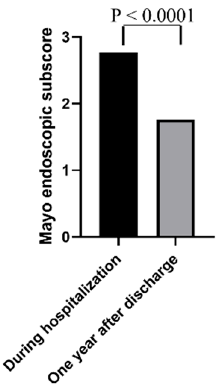
Figure 2. Kaplan–Meier curves of 88 patients with acute severe UC responding to intravenous corticosteroids (IVCS). Data about the relapse-free survival during the follow-up are shown according to maintenance therapy. 5-ASA = 5-aminosalycilic acid; IMMs = immunosuppressors.